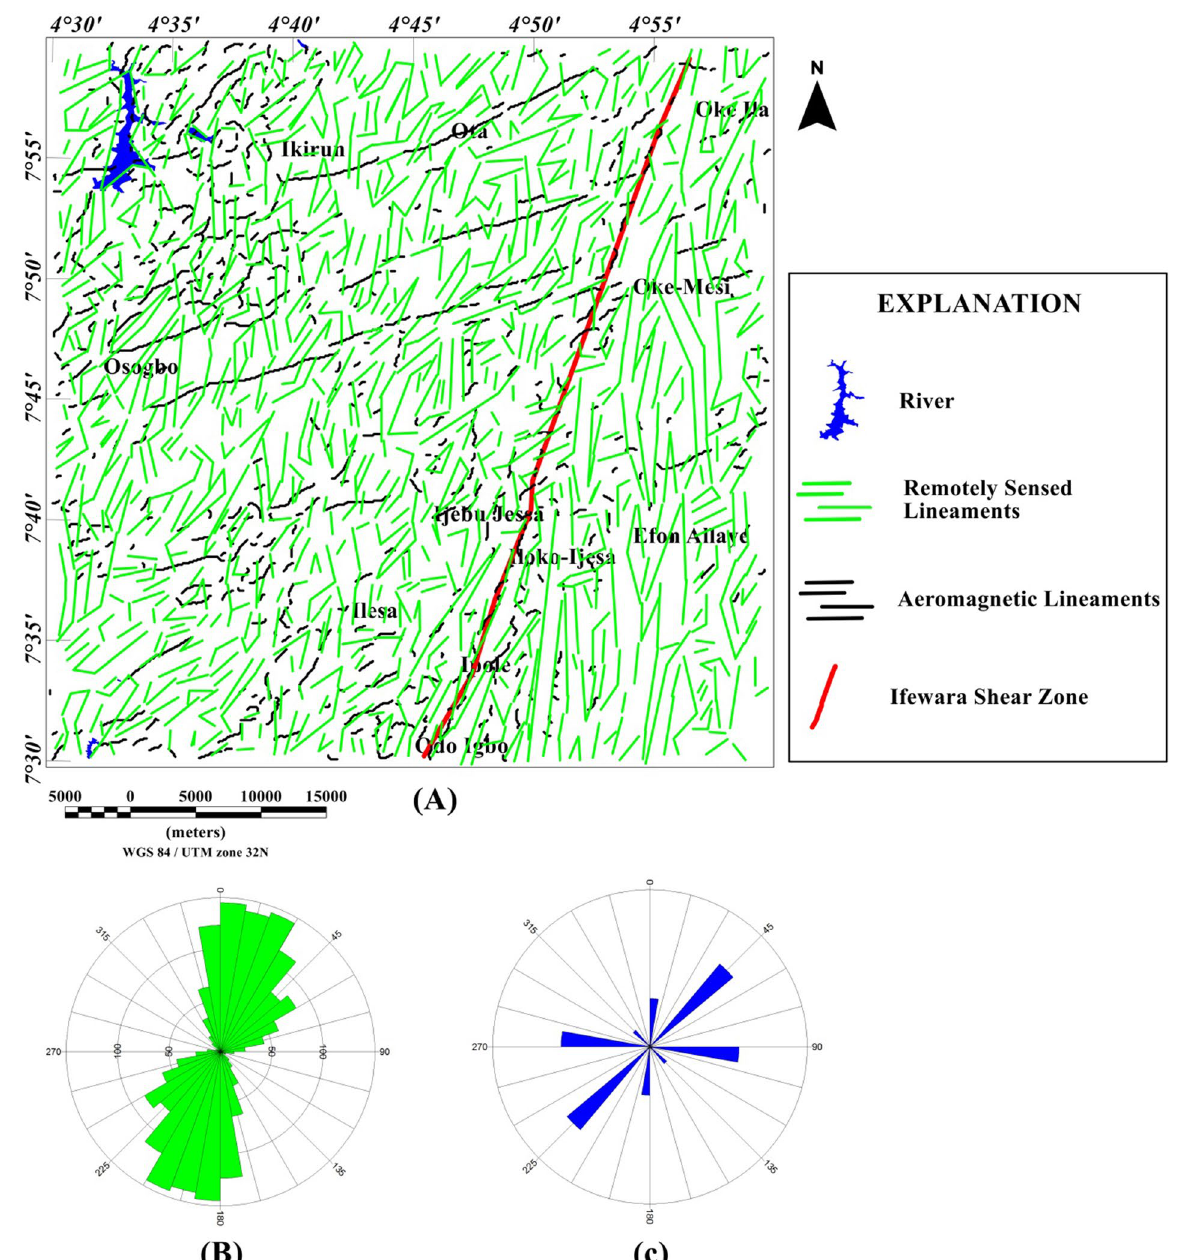
Figure 20. ( A ) Composite structural map of the Ife-Ilesha schist belt generated from the combined lineaments of SRTM (produced at 45° light angle at azimuths of 112.5°) and total gradient amplitude data. ( B ) Rose diagram of remotely sensed lineaments which offer trends patterns of surface lineaments. ( C ) Rose diagram of aeromagnetic lineaments which offer trends of subsurface lineaments. Note the extension of the Ifewara fault zone delineated from the total gradient amplitude data (indicated by as thick red line) coincides with some surface lineaments. Shuttle Radar Topography Mission image courtesy of the U.S. Geological